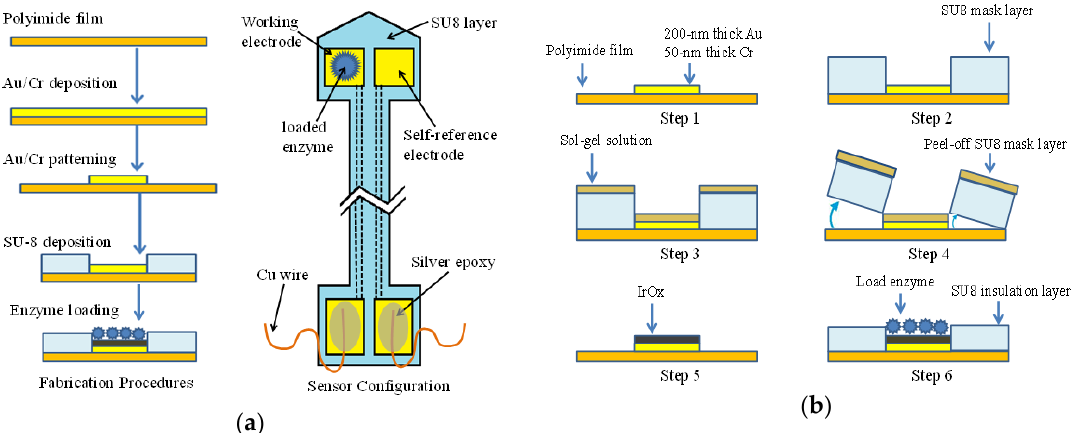
Figure 1. Fabrication process and sensor configuration: ( a ) gold electrode fabrication procedures and the sensor configuration; and ( b ) IrO x -modified electrode fabrication procedures.